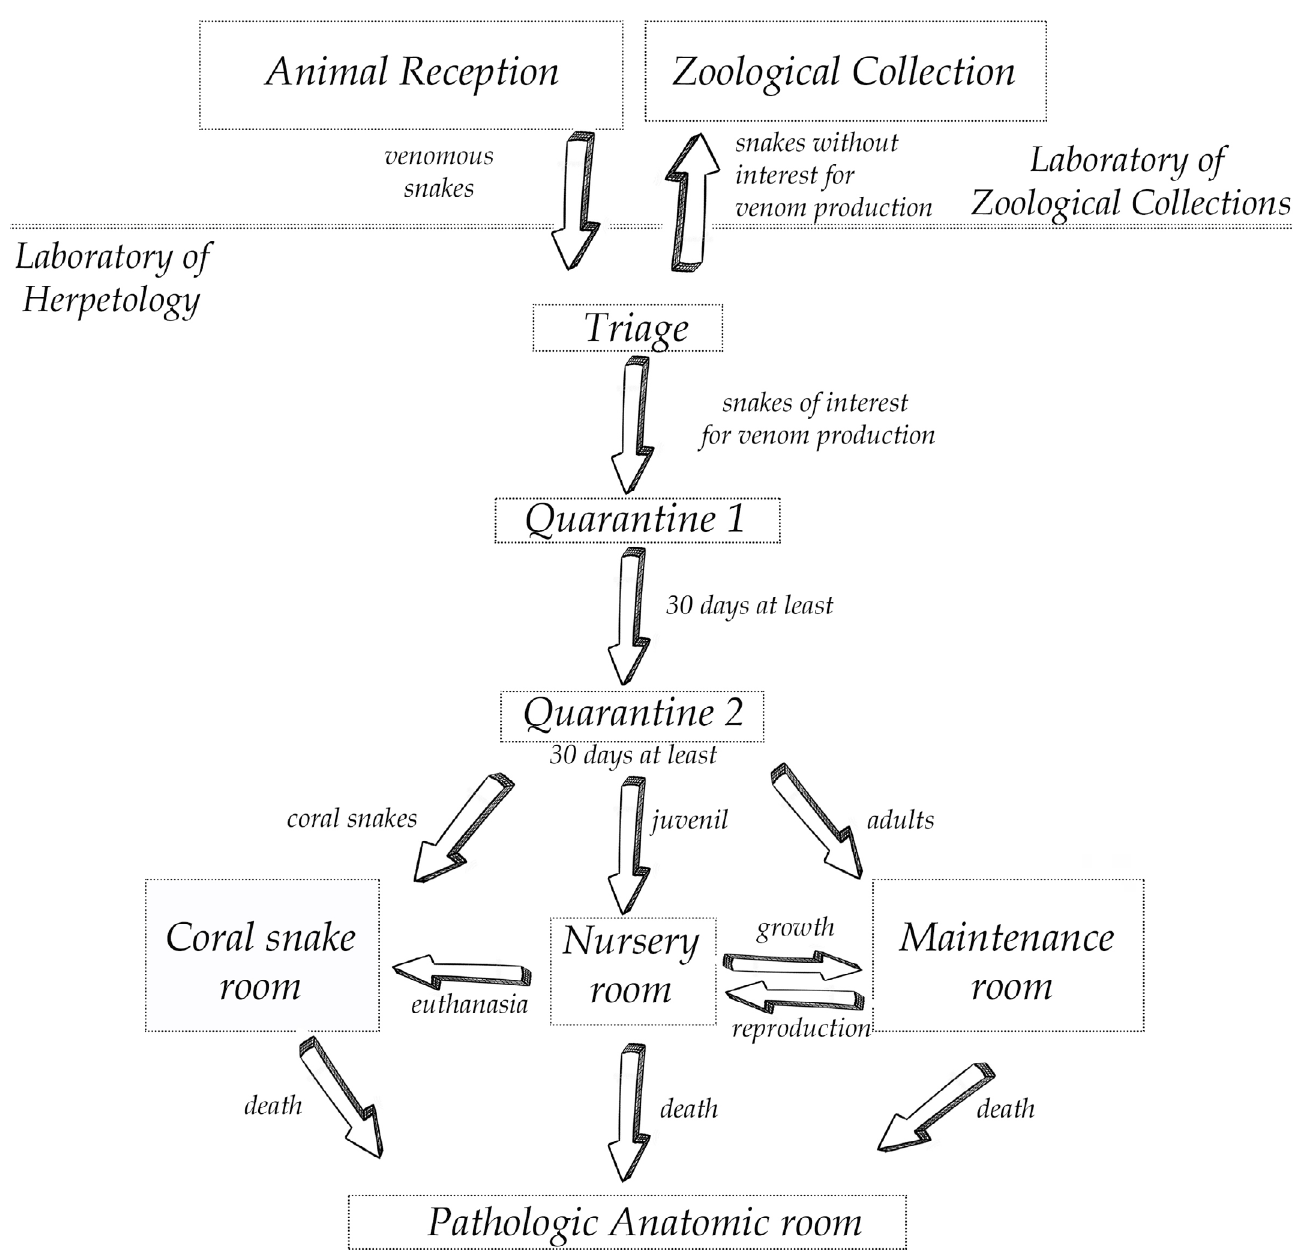
Figure 8. Traffic flow patterns at LH